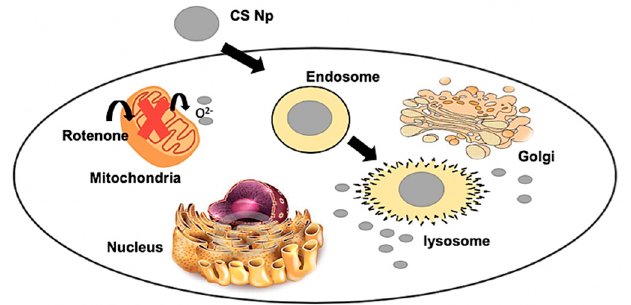
Figure 8. Mechanistic model of the action of chitosan nanoparticles.